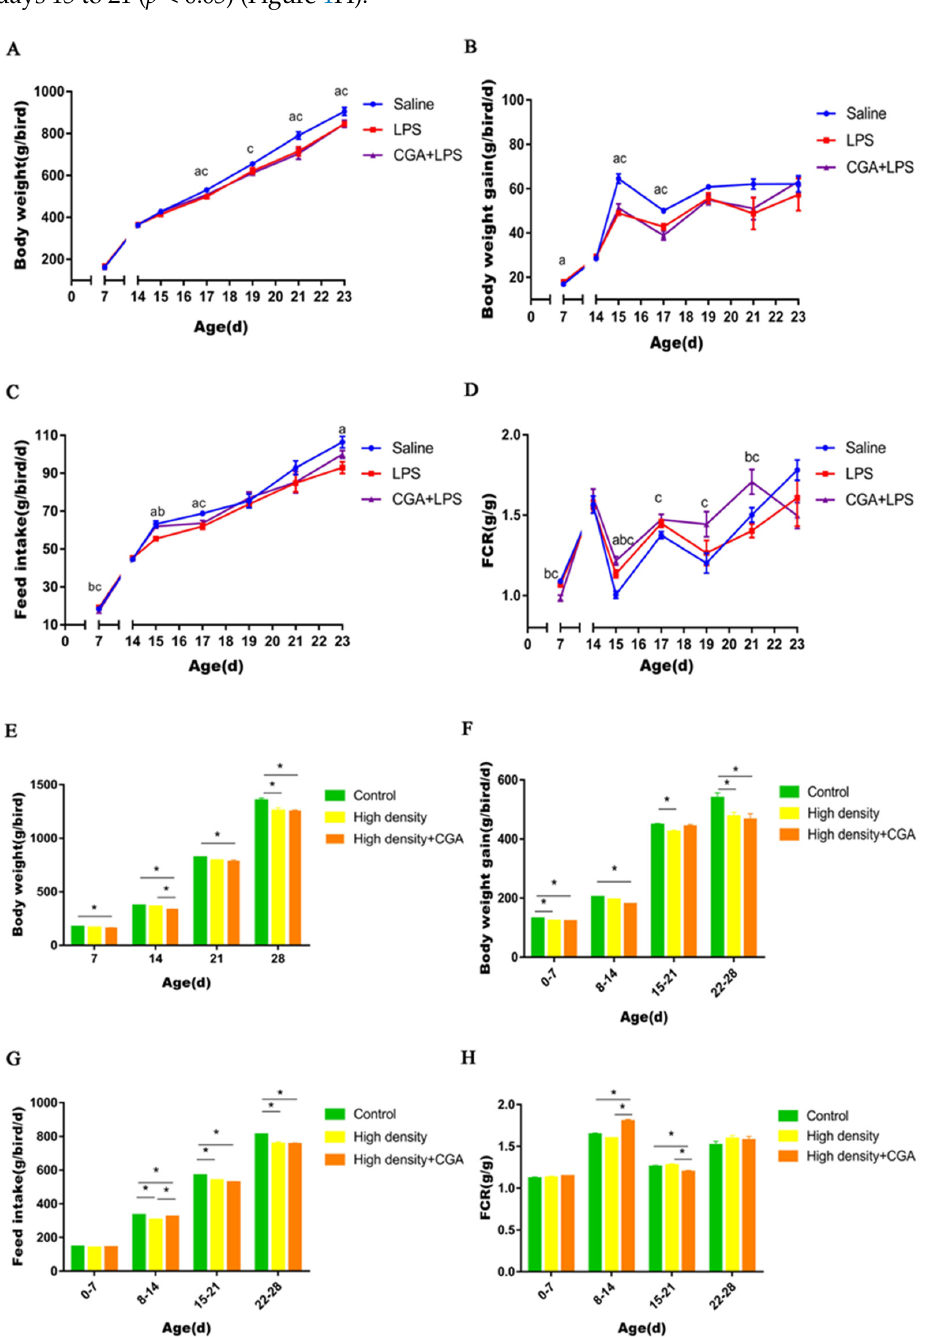
Figure 1. Effects of chlorogenic acid on broiler performance challenged with immune stress and high density stress. ( A ) Body weight of broilers challenged with immune stress. ( B ) Body weight gain of broilers challenged with immune stress. ( C ) Feed intake of broilers challenged with immune stress. ( D ) Feed conversion ratio of broilers challenged with immune stress. ( E ) Body weight of broilers challenged with high density stress. ( F ) Body weight gain of broilers challenged with high density stress. ( G ) Feed intake of broilers challenged with high density stress. ( H ) Feed conversion ratio of broilers challenged with high density stress. a means significant difference between Saline and LPS groups, b means significant difference between LPS and CGA + LPS groups, c means sig- nificant difference between Saline and CGA + LPS groups, and * means significant difference be- tween groups.